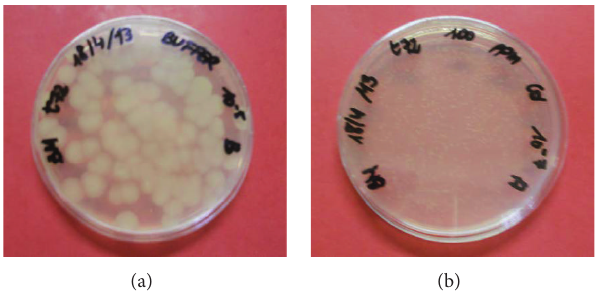
Figure 4: Growth of Bacillus mucilaginosus on nutrient agar plates. (a) Blank reference strain (after 72 hours of growth in batch culture, resulting in typical colony morphology on agar plate). (b) Strain that hadpreviouscontactwithCd(II)inabatchculturefor72hours(note smaller colonies and the absence of mucous generation).